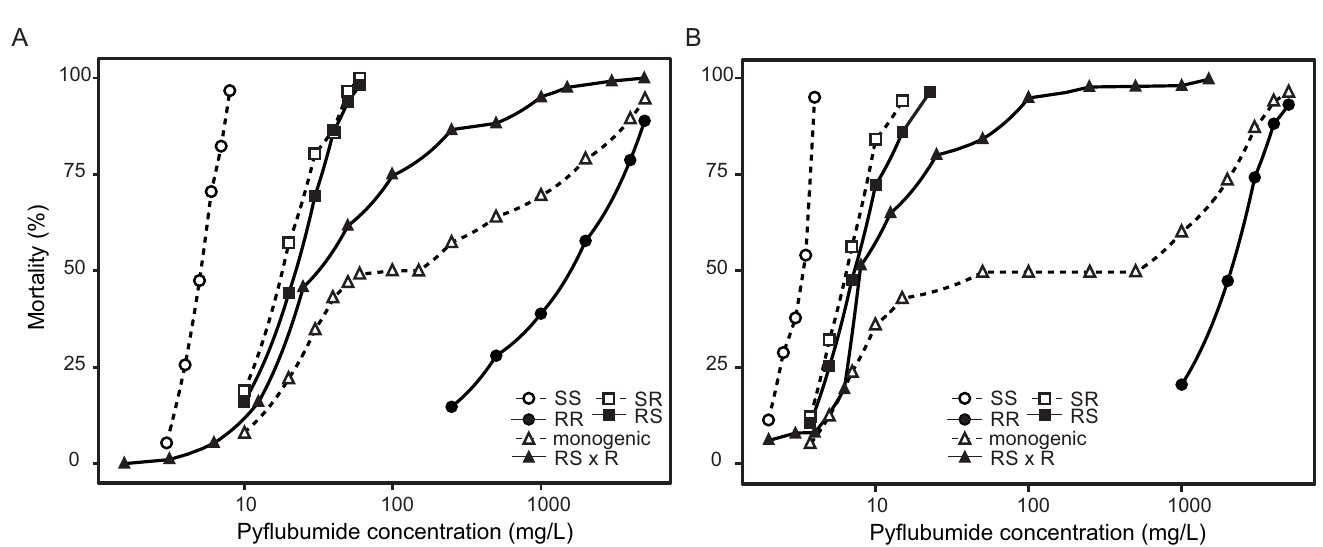
Fig 1. Pyflubumide resistance has a polygenic basis in JPR-R1 and JPR-R2. (A) Dose-response relationships of pyflubumide toxicity on JPR-R1, JP-S (circles), reciprocal crosses (squares), and back-crosses (triangles). (B) Dose-response relationships of pyflubumide toxicity on JPR-R2, Wasatch (circles), reciprocal crosses (squares), and back-crosses (triangles). Panels show that pyflubumide resistance has an incomplete recessive mode of inheritance in both resistant strains. After back- crossing, the observed dose-response relationships significantly differ from those calculated under the hypothesis of a recessive monogenic mode of inheritance (p < 0.001) (black versus white triangles, respectively), indicating that pyflubumide resistance is determined by multiple loci in both JPR-R1 and JPR-R2.